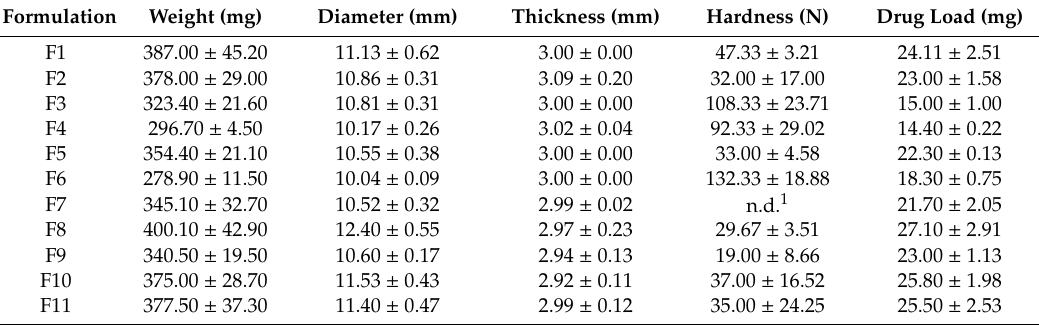
Table 3. Measured tablet weight, dimensions, hardness, and drug load (mean ± SD)